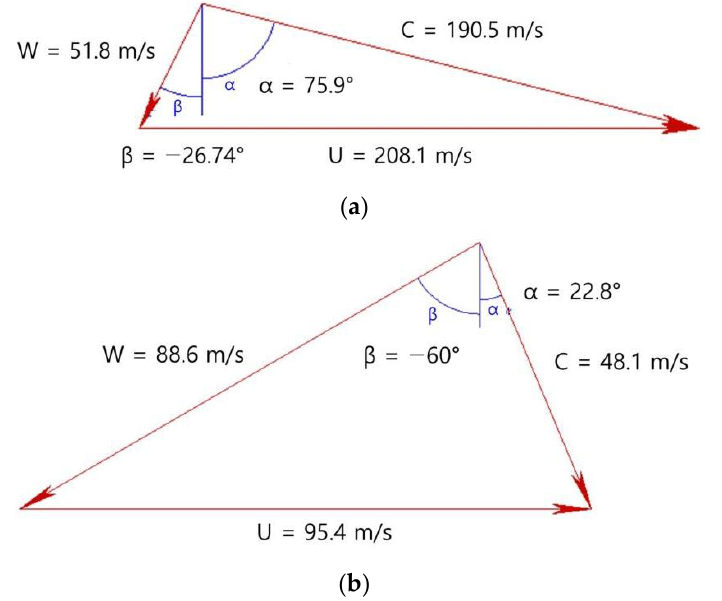
Figure 3. Velocity triangles at design points: ( a ) rotor inlet (incidence angle − 26.74°) and ( b ) rotor outlet (deviation angle 22.8°).